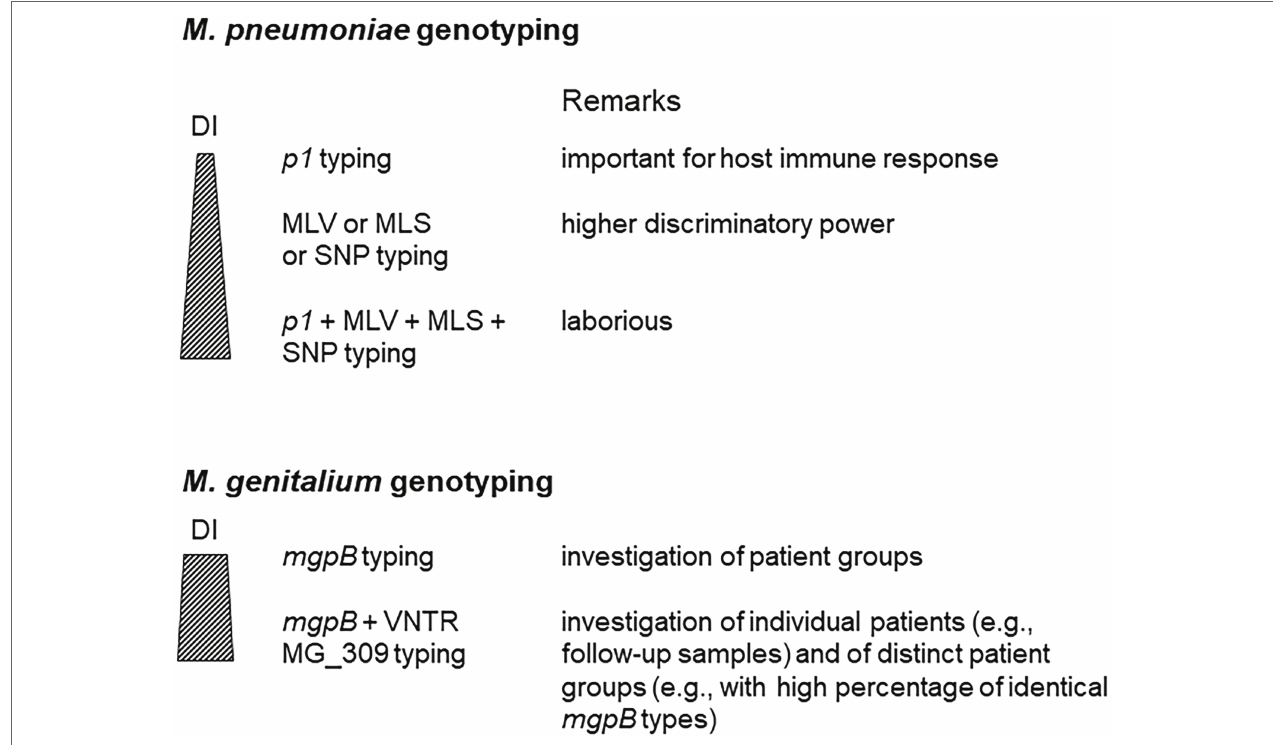
FIGURE 4 | Use of different approaches for Mycoplasma pneumoniae and Mycoplasma genitalium typing. DI, discriminatory